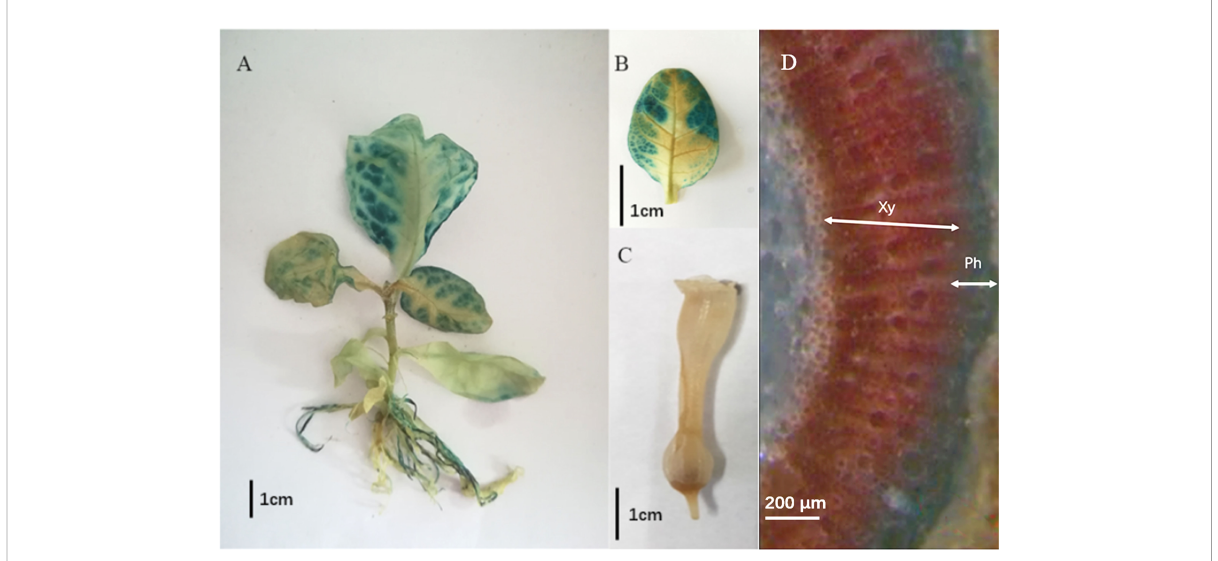
FIGURE 5 Expression of pDfSUT4::GUS in N. tabacum . (A) Intact plant. (B) Leaf. (C) Flower. (D) Stem section. Xy, xylem, Ph,